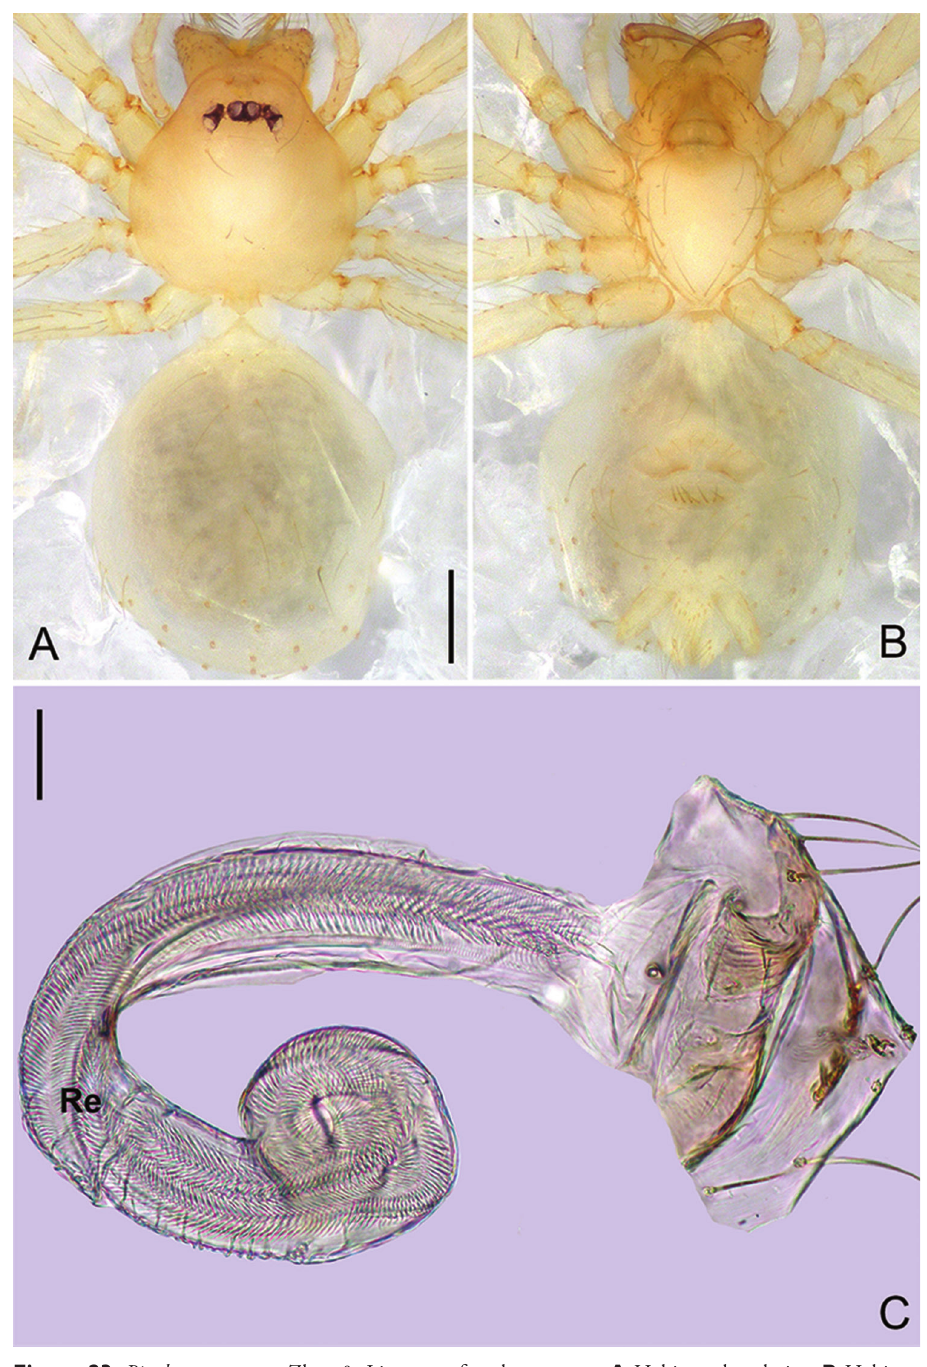
Figure 23. Pinelema wenyang Zhao & Li, sp. n., female paratype. A Habitus, dorsal view B Habitus, ventral view C Endogyne, lateral view. Scale bars: 0.2 mm ( A–B ), 0.05 mm ( C